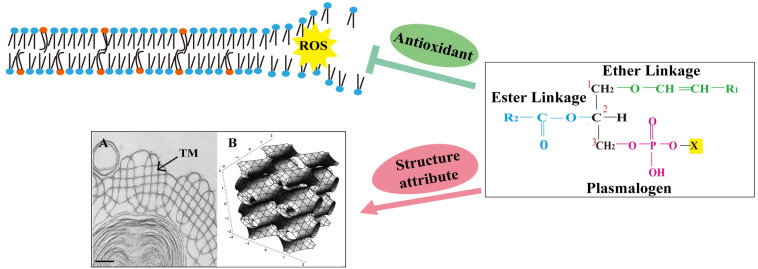
The chemical structure of plasmalogen and its potential role in lung surfactant. Plasmalogens are a class of phospholipids carrying a vinyl ether bond at sn-1 and an ester bond at sn-2 position of the glycerol backbone. The vinyl ether bond at sn-1 position is highly prone to attack by reactive oxygen species (ROS). This was proposed to prevent the oxidative damage of polyunsaturated fatty acids and other vulnerable membrane lipids, suggesting a role for plasmalogens as sacrificial molecules (antioxidant). Plasmalogens also promote the formation of non-lamellar membrane structures, including tubular myelin (TM) (a deformed P-cubic structure). Orange spheres mark plasmalogens, and blue spheres mark other phospholipids. (A) Transmission electron microscopy (TEM) image containing TM structure (arrow) was adapted from Williams (1977) with permission; scale bar = 100 nm. (B) A tP model of TM bilayer structure with the minimal surface describes the center of the bilayer. Adapted from Larsson and Larsson (2014) with permission.